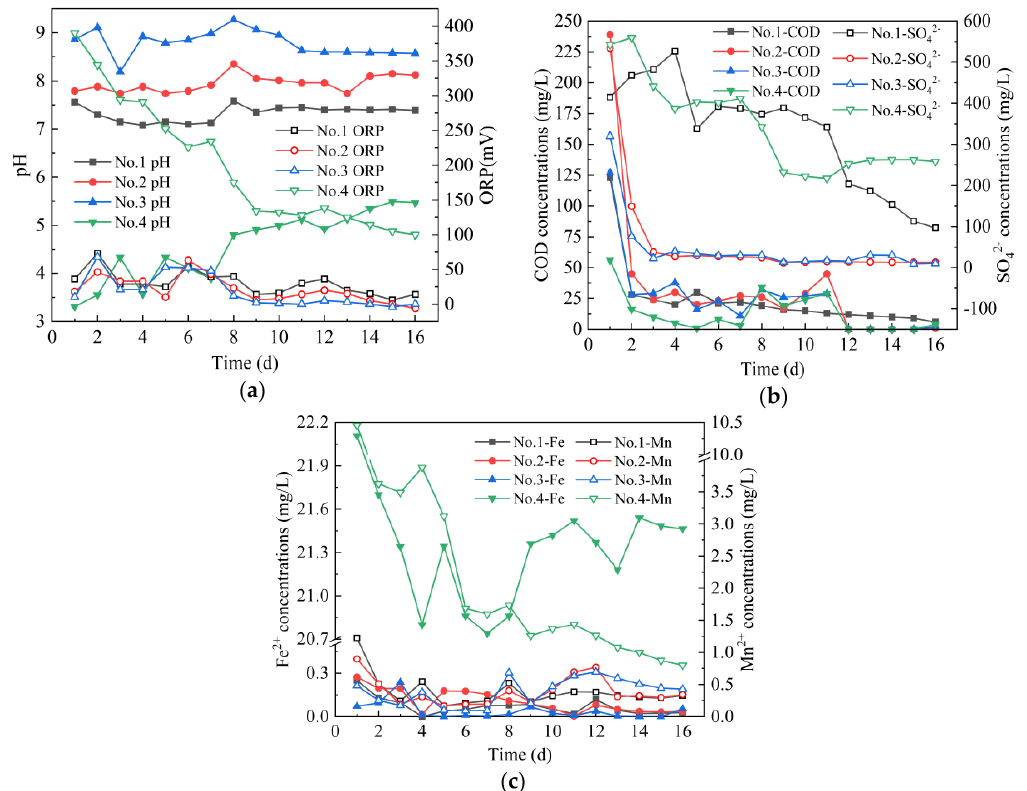
Figure 2. Changes of dynamic leaching indexes of Coal Gangue 1–4. ( a ) pH and oxidation reduction potential (ORP) values; ( b ) chemical oxygen demand (COD) and SO 42− concentrations; ( c ) Fe 2+ and Mn 2+ concentrations.